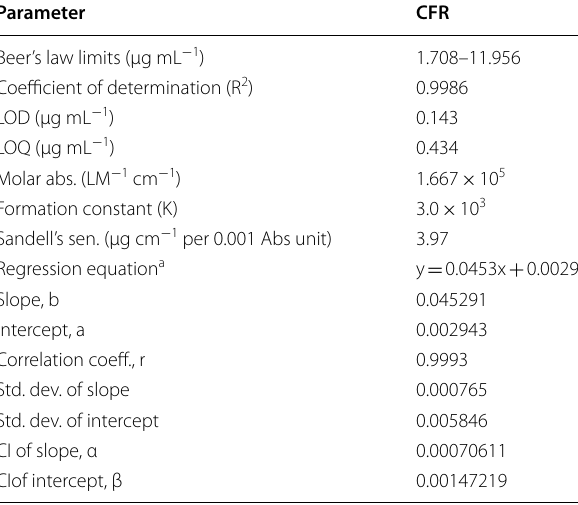
Table 2 Analytical and validation parameters for the reaction of